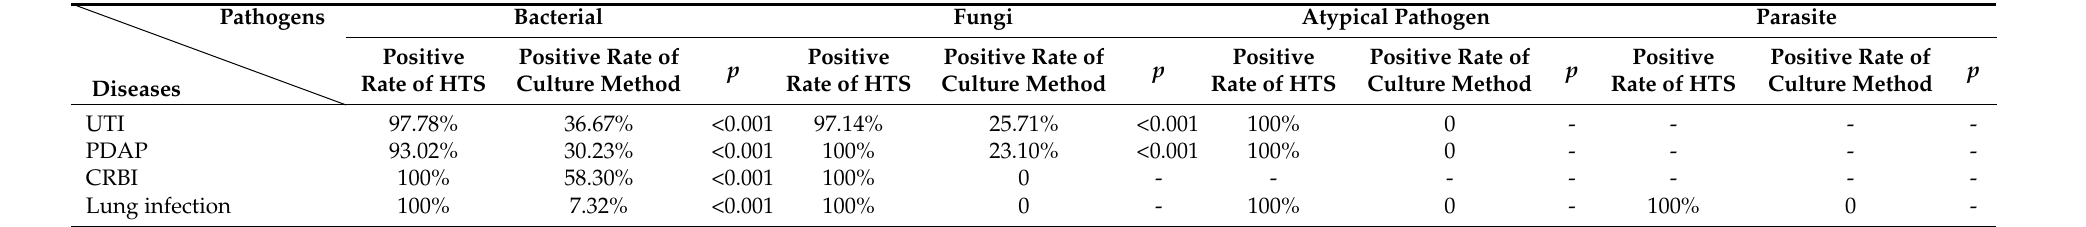
Table 3. Comparison of the effectiveness between high-throughput sequencing and the culture method in detecting